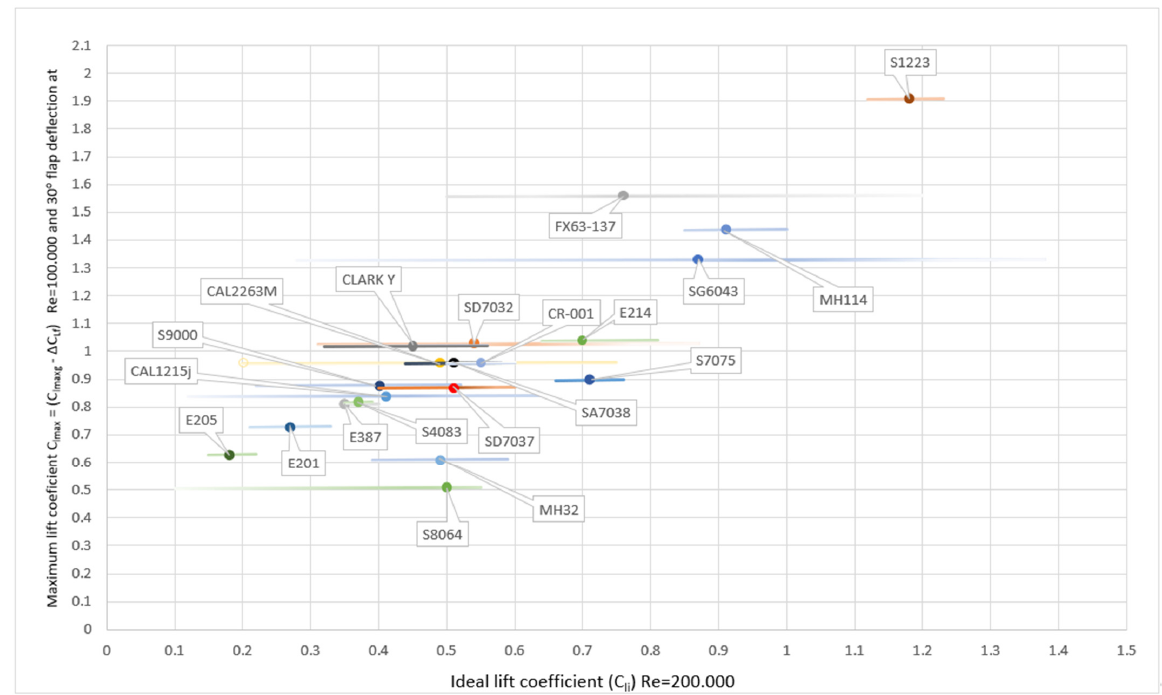
Figure 8. The constructed C lmax − C li diagram (the diagram along with raw data can be found in .xlsx format in Table S2). .xlsx format in Table